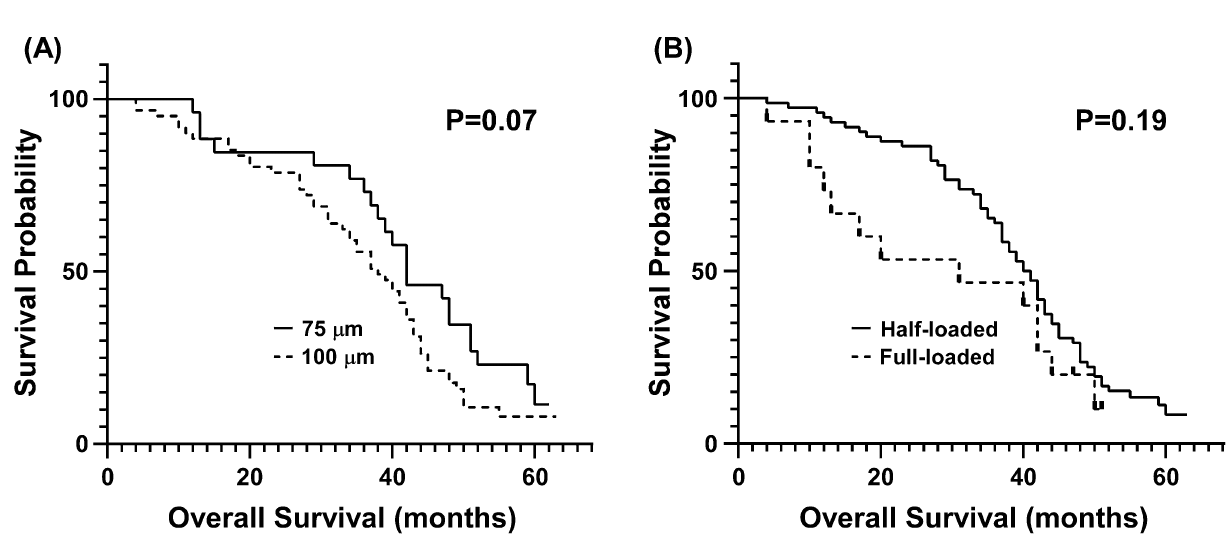
Table 5. Adjusted association of TANDEM size and drug-loading concentration with clinical outcomes and biochemical measures in patients with hepatocellular carcinoma. a Logistic regression was performed after adjusting for age, gender, CLIP stage, Child–Pugh Score, and total doxorubicin dosage. Odds ratio and 95% CI were presented. b Linear regression was performed after adjusting for age, gender, CLIP stage, Child–Pugh Score, and total doxorubicin dosage. The regression coefficients (β) indicated the difference in days between TANDEM size or doxorubicin-loading groups.